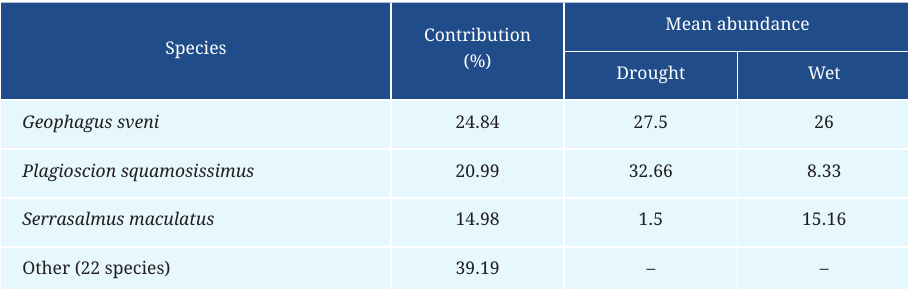
TABLE 2 | Contribution of species to the percentage of dissimilarity (SIMPER) of the ichthyofauna in the control area considering abundance data for the drought and wet seasons at the Ilha Solteira reservoir, Upper Paraná River, SP,